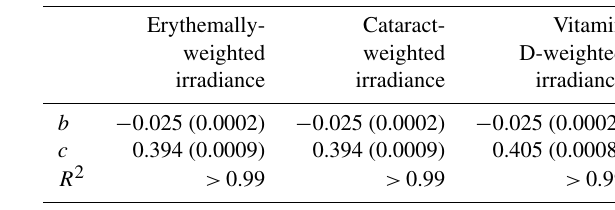
Table 2. The coefficients for calculating the r bio values (Eq. 21) for different types of BAUVR. Model estimations. The standard error of the coefficients is given in the brackets at P =